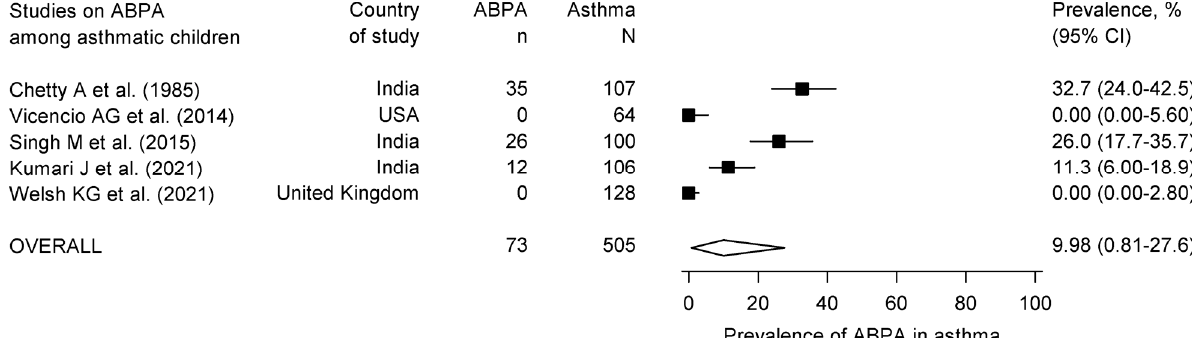
Figure 4. Forest plot showing the pooled prevalence of allergic bronchopulmonary aspergillosis in pediatric asthma. The prevalence in individual studies is shown by the black square with horizontal bars indicating the 95% confidence interval. The diamond denotes the pooled prevalence with a 95% confidence interval [9,40,46,47,53].